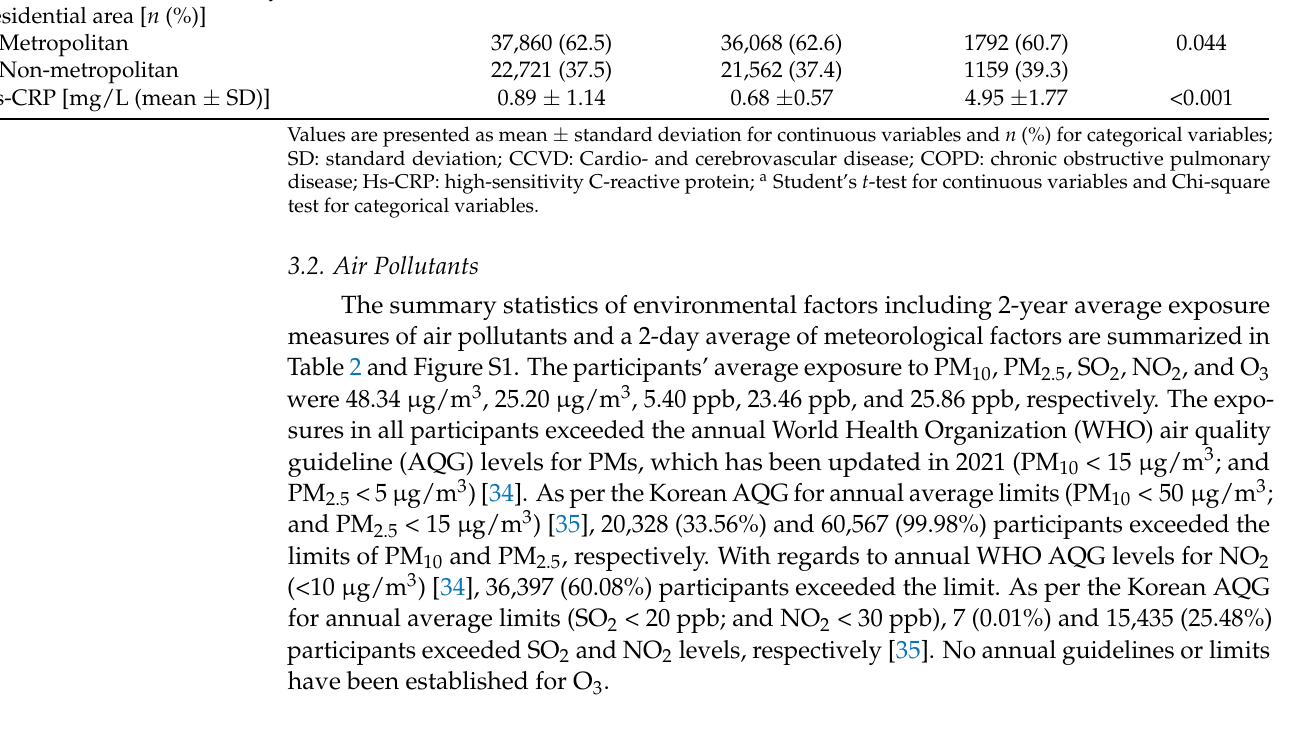
Table 2. Summary statistics of the residential air pollution exposure (2-year average) and meteorolog- ical factors (2-day average), and corresponding Spearman correlation